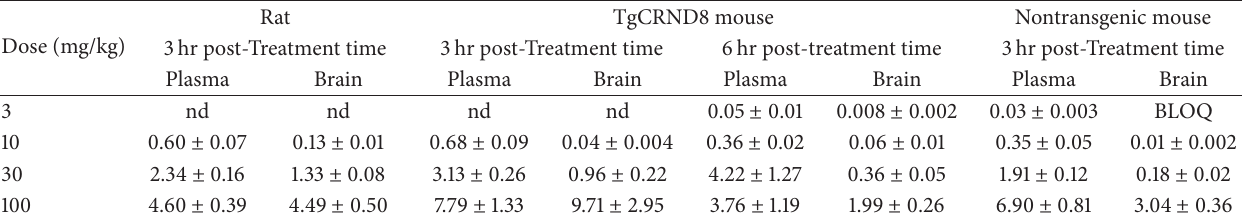
Table 2: Concentration of SCH 697466 ( 𝜇 M) in plasma and brain for various acute studies in rats, TgCRND8 mice and non-transgenic mice. Rat TgCRND8 mouse Nontransgenic mouse Dose (mg/kg) 3hr post-Treatment time 3 hr post-Treatment time 6hr post-treatment time 3hr post-Treatment time Plasma Brain Plasma Brain Plasma Brain Plasma Brain 3 nd nd nd nd 0.05 ± 0.01